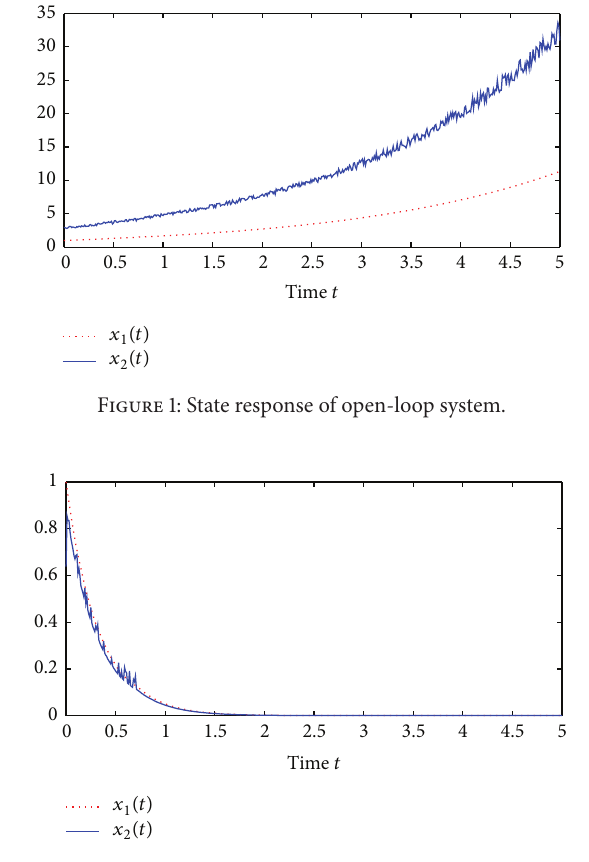
Figure 2: State response of closed-loop